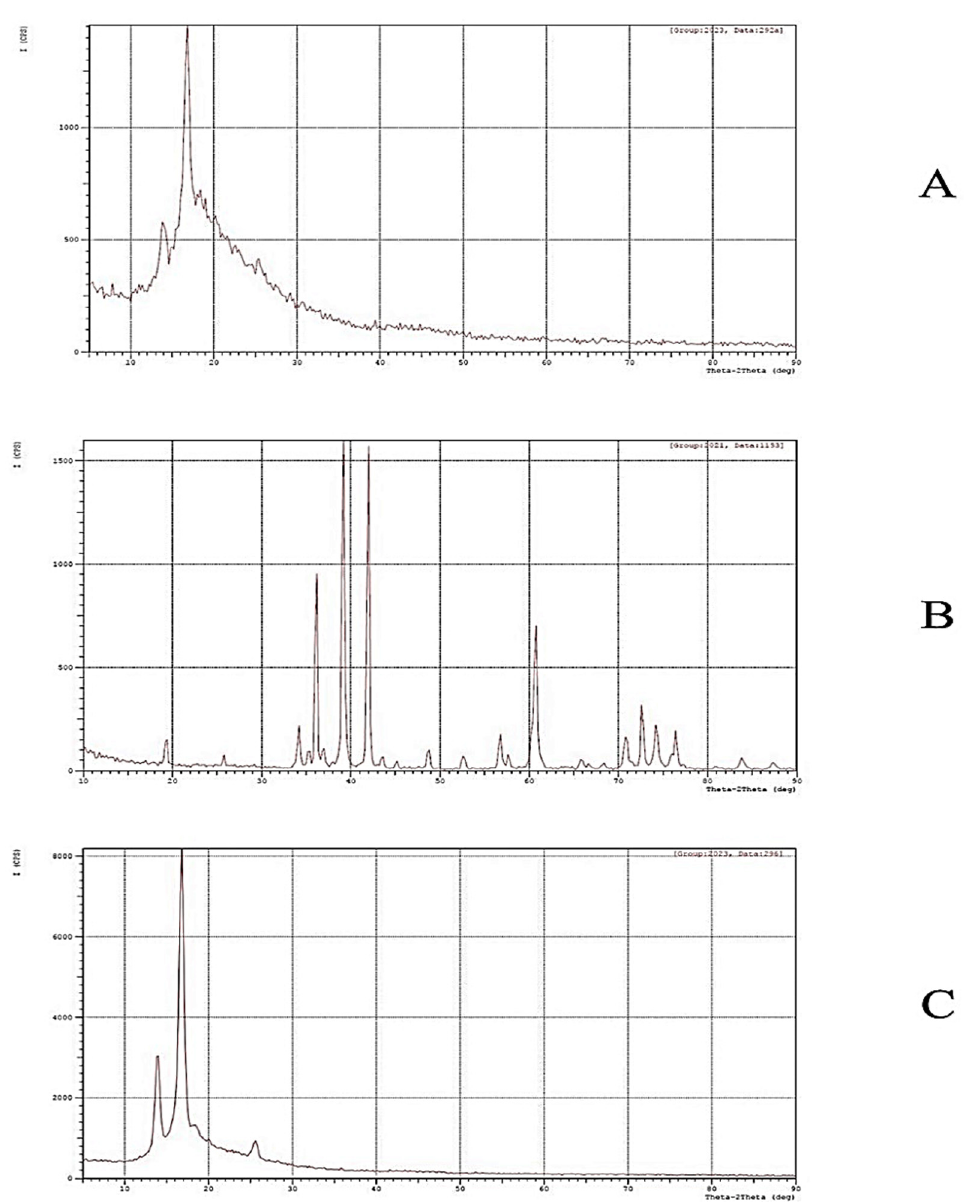
Figure 5. X-ray diffraction of ( A ) PPSU membrane, ( B ) MXene powder and 1.5 wt.% MXene-modified Figure 5. X-Ray di ff raction of ( A ) PPSU membrane, ( B ) MXene powder and 1.5 wt.% MXene- modi fi ed NF membranes ( C ). NF membranes ( C